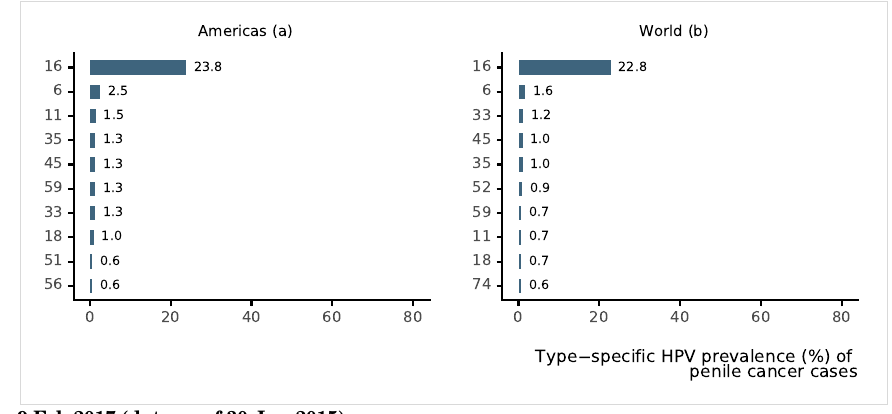
Figure 68: Comparison of the ten most frequent HPV types in cases of penile cancer in Americas and the World